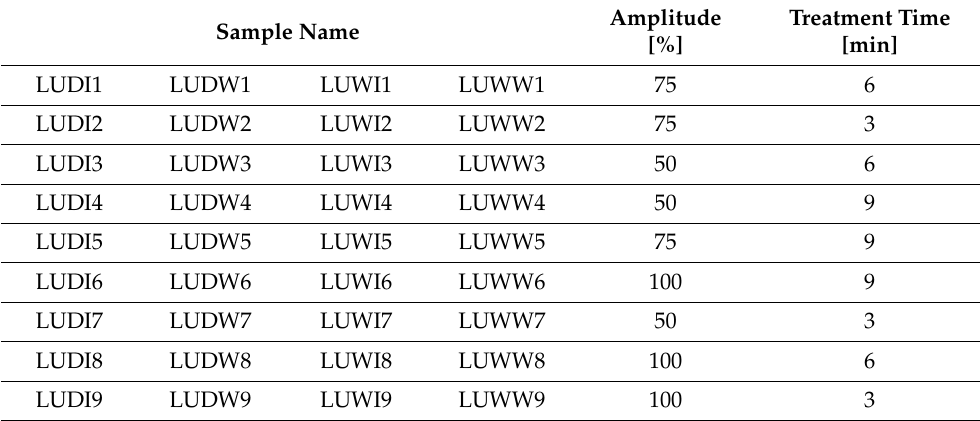
Table 1. Variations of parameters (amplitude and time) of ultrasound-assisted extraction for individ- ual samples.